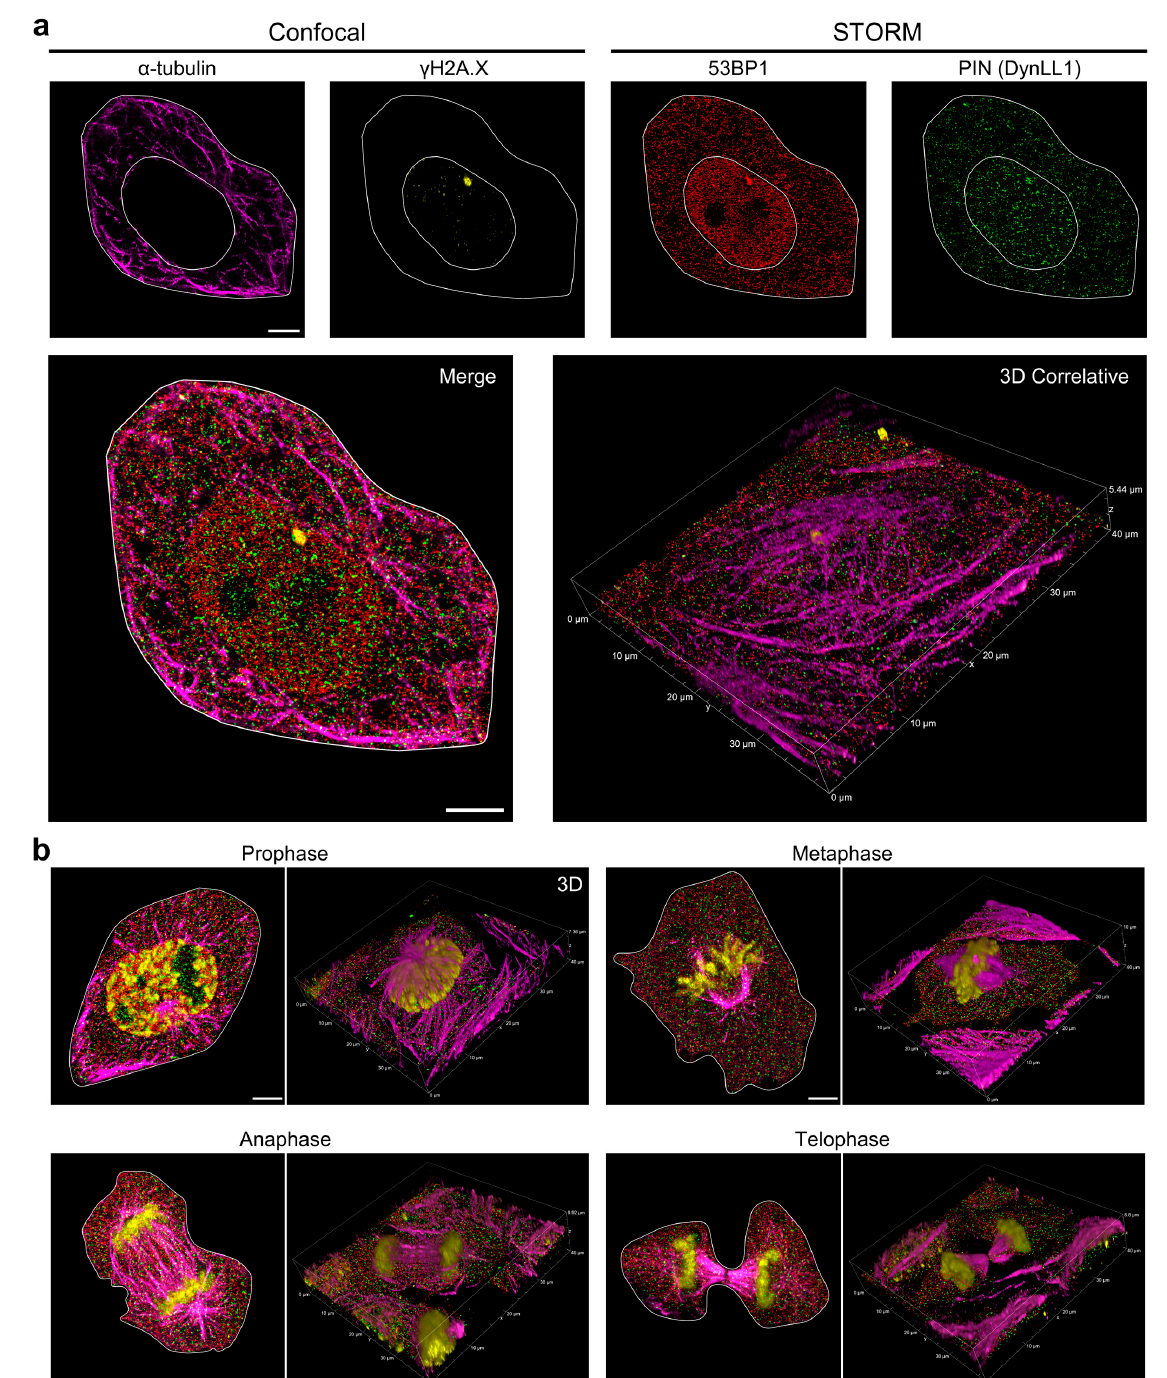
Figure 6. Correlative Confocal-dSTORM Analysis on Image-Cytometry re-localized cells. ( a ) Repre- sentative re-localized G1 cells acquired by the correlative Confocal-STORM protocol described in the text. Confocal Z-Stacks were first acquired of the Tubulin-Atto425 and γ H2A.X-Alexa488 fluorescence channel, followed by acquisition of the 53BP1-Cy3 and DynLL1-Alexa Fluor647 channels in dSTORM. The dSTORM plane is identified in the Z-Stack, aligned and merged in the plane (merged image in the second row on the left) and then inserted into the Z-stack (3D projection on the right). ( b ) The described correlative microscopy procedure was applied to cells in the different stages of mitosis, isolated according to the image-cytometry analysis. Z-stacks merged with the dSTORM plane of some representative cells are shown. Scale bar: 5 µ